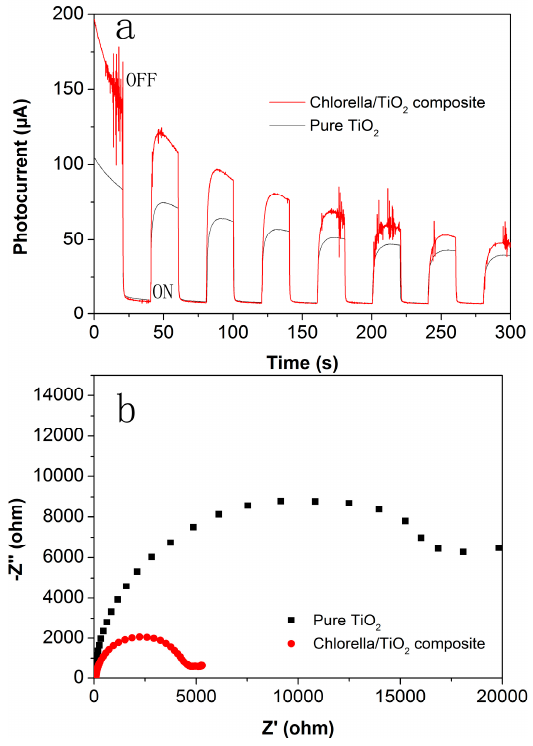
Figure 6. Surface photocurrent (SPC) ( a ) and electrochemical impedance spectroscopy (EIS) ( b ) results of the samples.